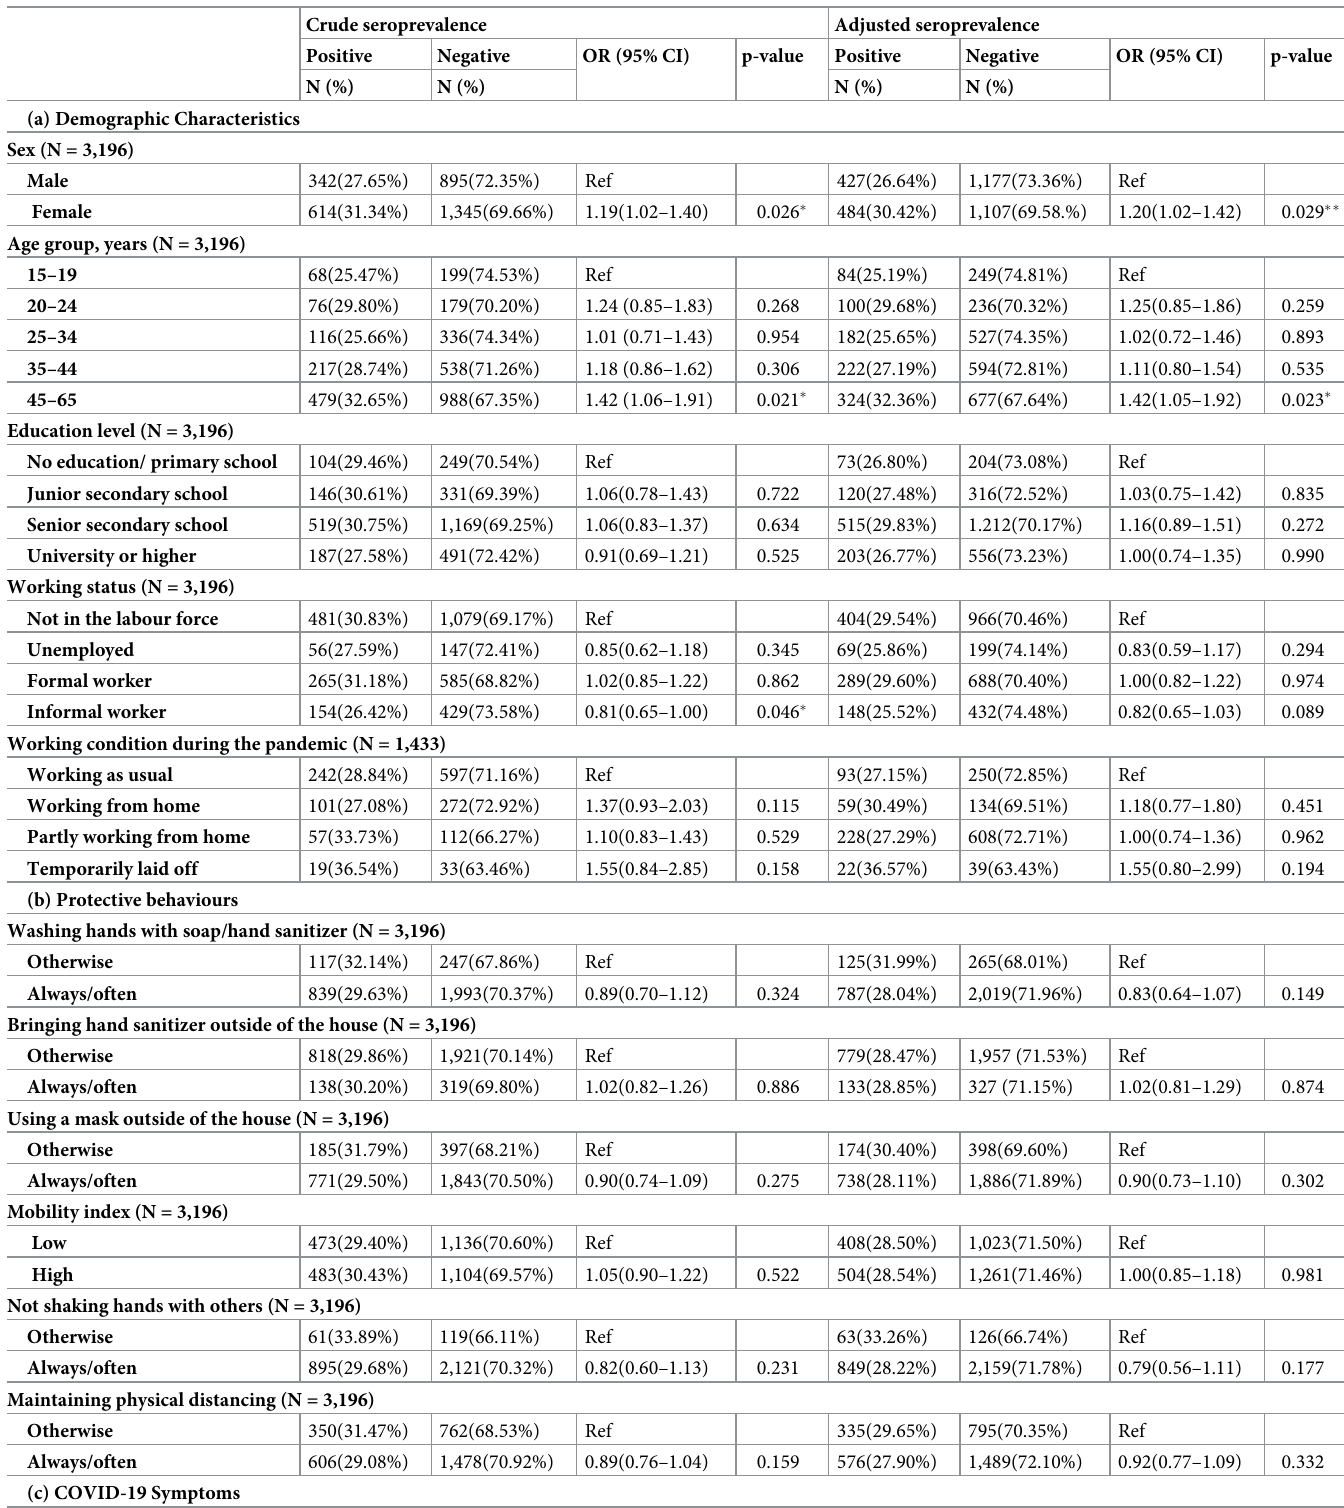
Table 3. Seroprevalence by demographic